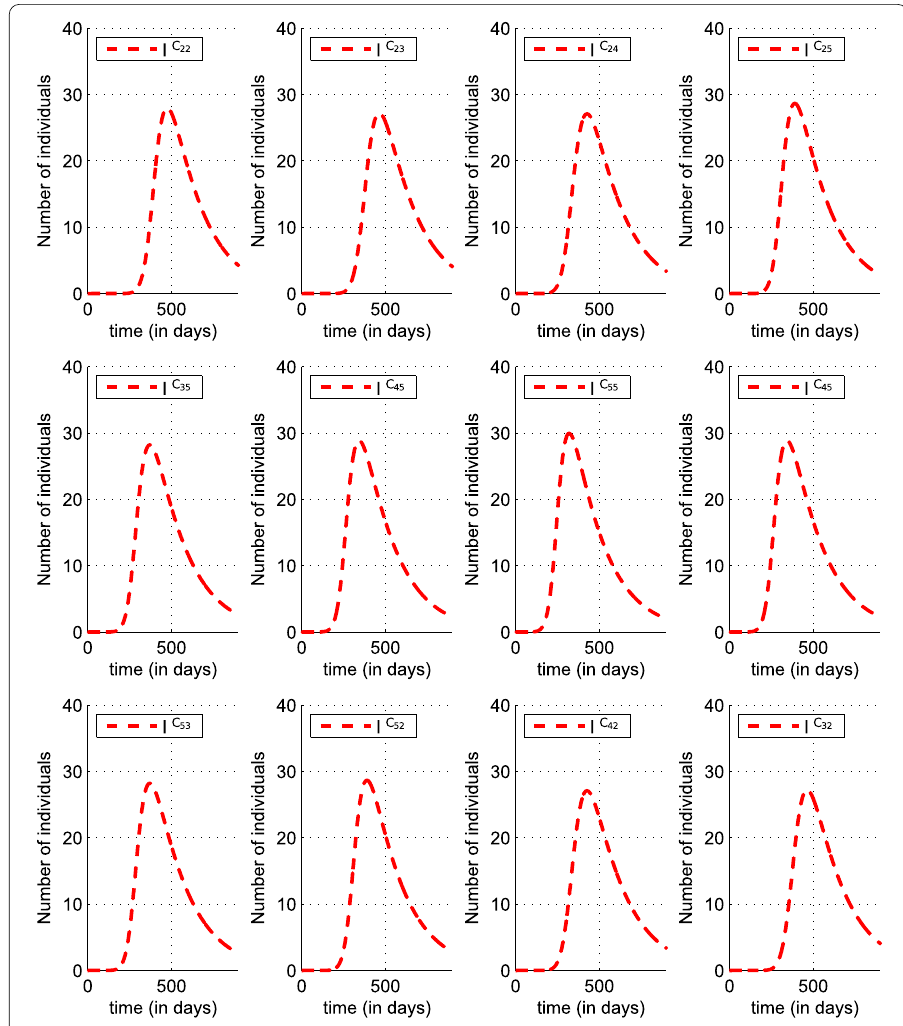
Figure 21 I Crs behavior in the vicinity set V P , with C rs ∈ V P